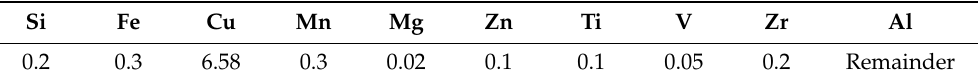
Table 1. Chemical compositions of AA2219 [25] (percent by